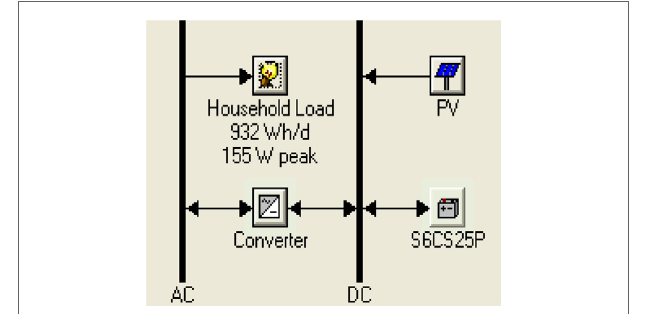
FigUre 5 | The network architecture for the hOMer simulator (0.52 kW PV energy system) .